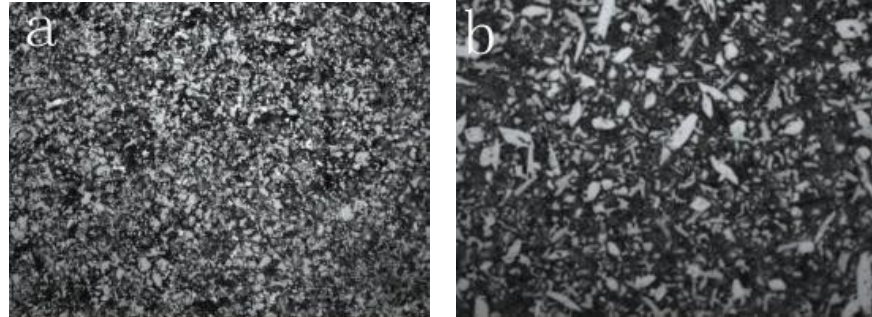
Figure 6. Microstructure of ( a ) the Ni60A coating and ( b ) the NiCrMoY coating.